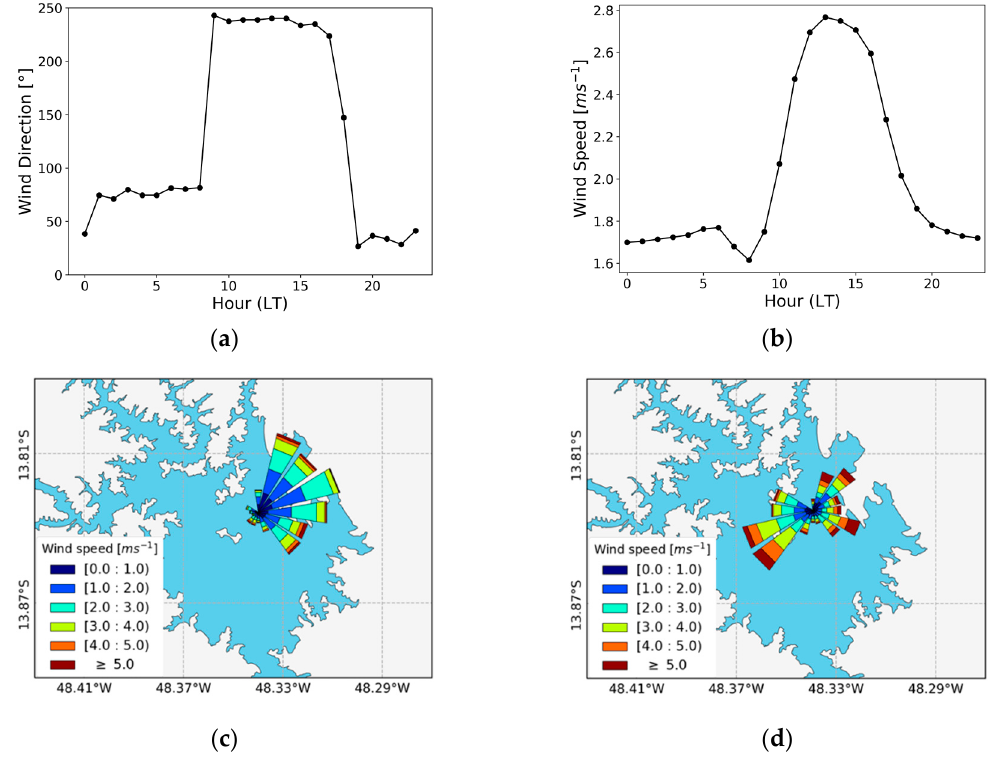
Figure 5. Diurnal cycle of mean hourly wind: ( a ) direction (mode) and ( b ) speed. Wind rose for data acquired ( c ) from 20h till 09h LT and ( d ) from 10h till 17h LT. Obtained from data acquired in the period from 2005 to 2010.